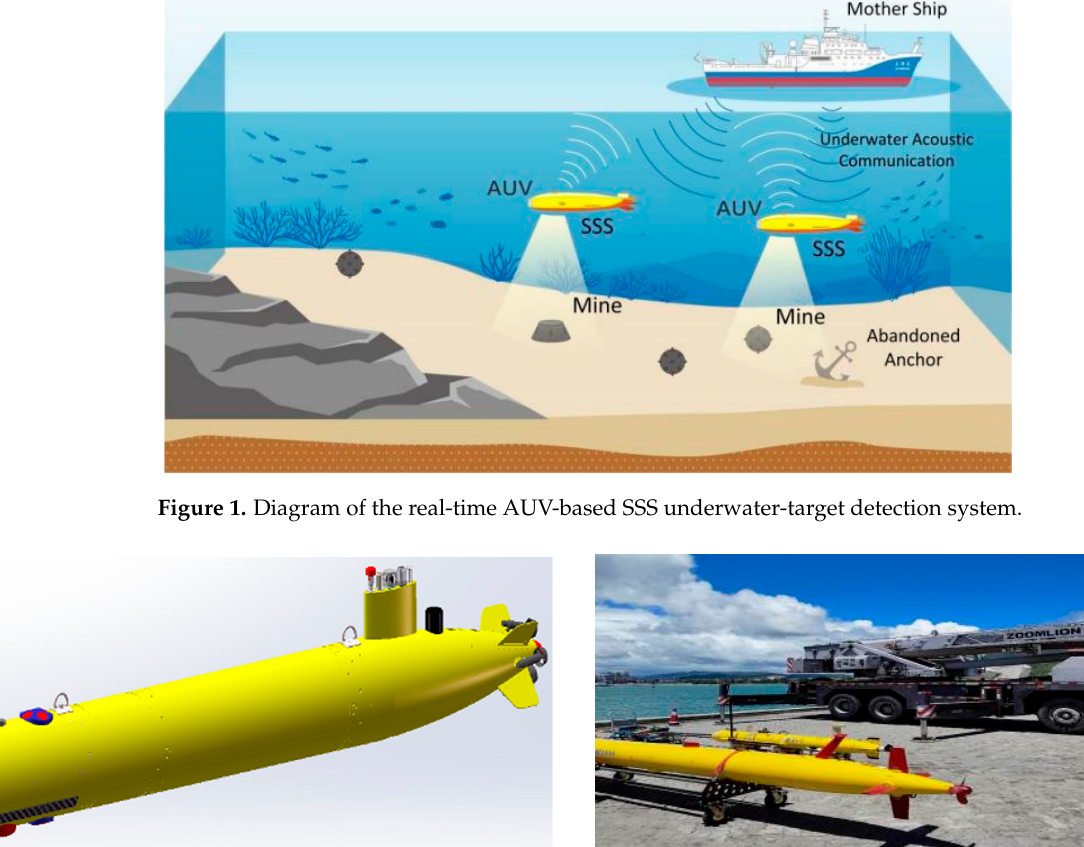
Figure 2. Black Shark I-A AUV. ( a ) Overall diagram of the AUV. ( b ) Real AUV at the